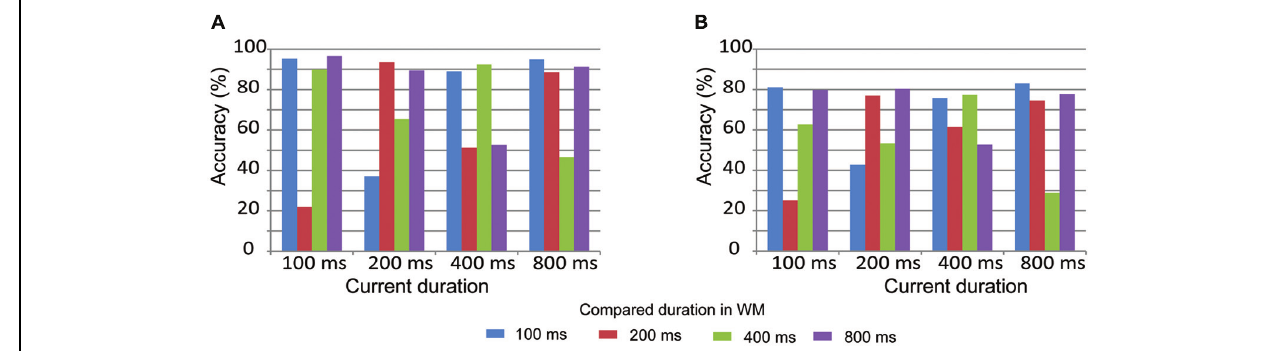
FIGURE 3 | Pairwise comparisons of duration accuracy in the LL (A, 1-back task) and HL (B, 2-back task) conditions.